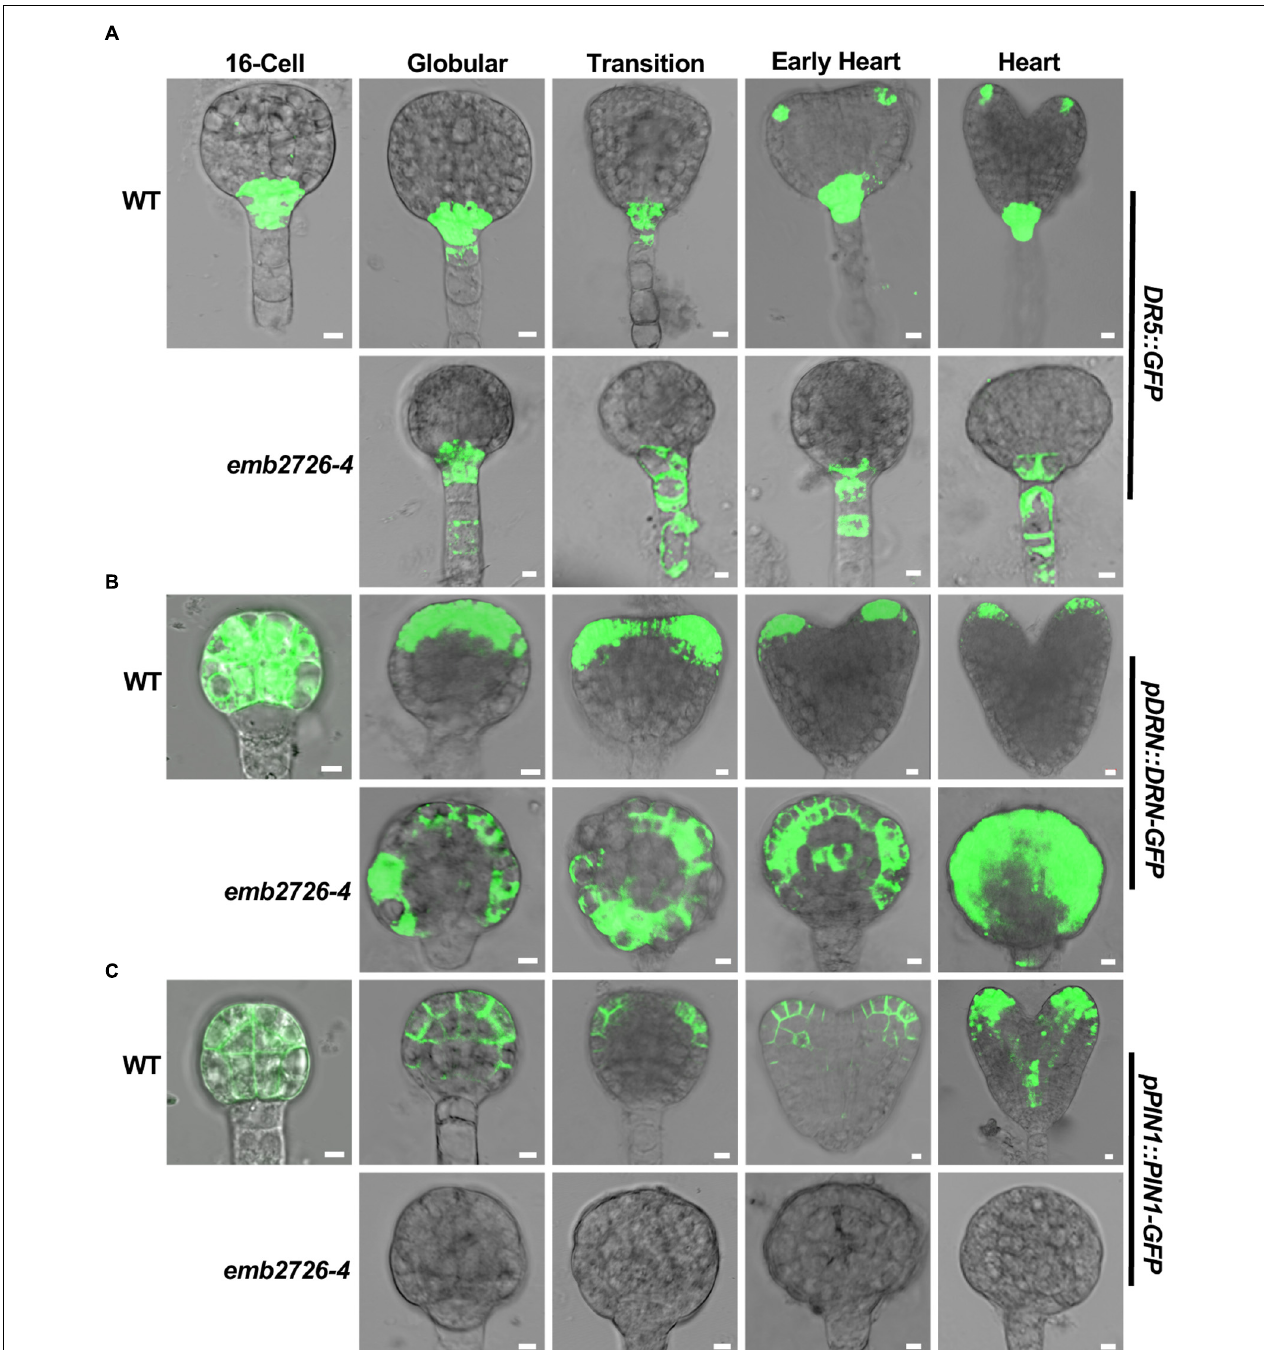
FIGURE 6 | Polar auxin transport is altered in emb2726-4 embryos. Expression patterns of DR5:GFP (A) , pDRN:DRN-GFP (B) , and pPIN1:PIN1-GFP (C) in WT and emb2726-4 embryos at different developmental stages. A minimum of 50 embryos were observed for 16-cell stage embryos, and 30 WT and 30 mutant embryos were observed for each of the later developmental stages. Scale bar = 10 µ